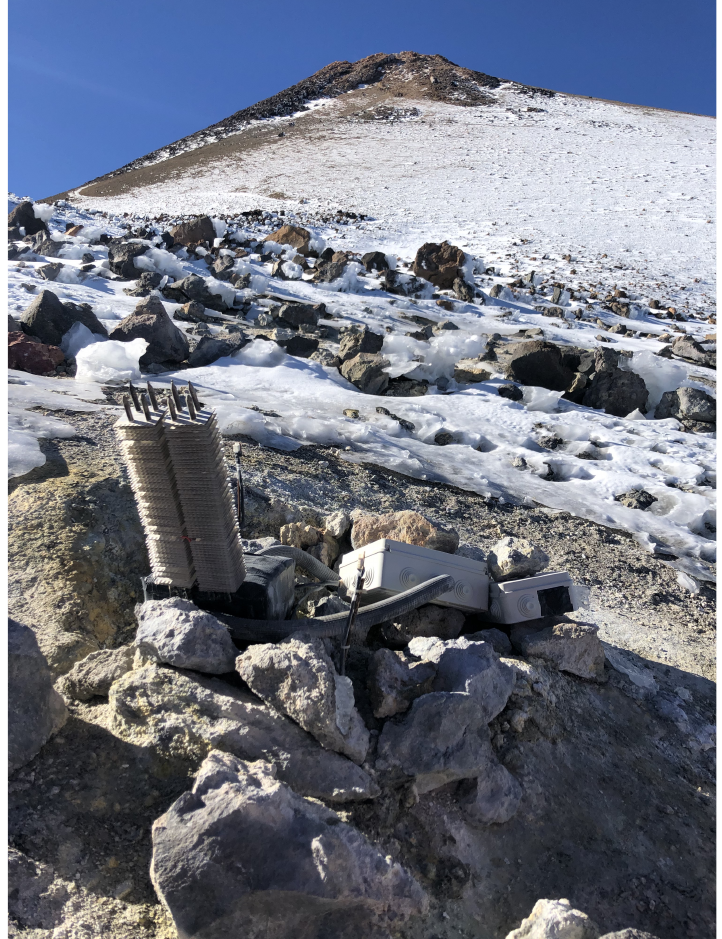
Figure 7. Prototype installed at Teide